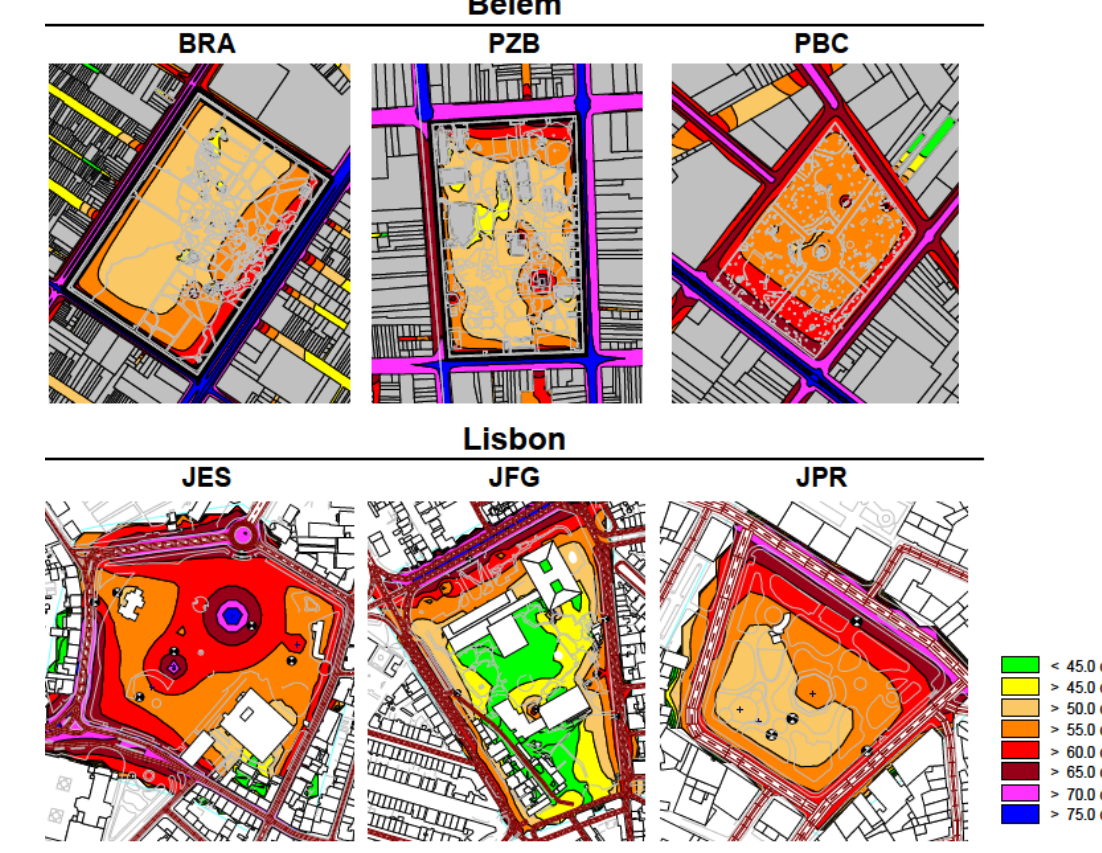
Figure 4: Sound maps of parks in Belém and in Lisbon.